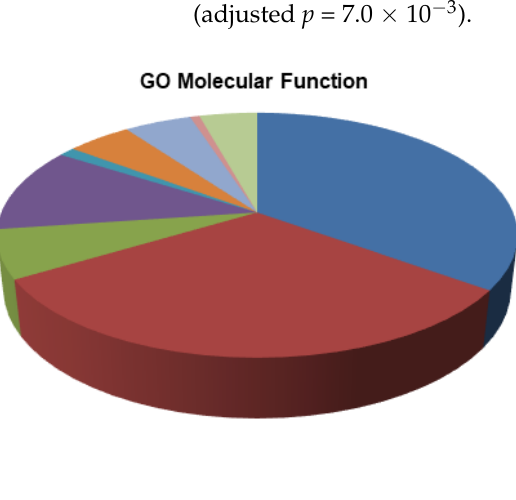
Figure 5. Transcripts per million (TPM) in normal (green) and tumor (red) lung tissues of those genes identified as strongly validated miRNA targets. ( A ) C19MC cluster and ( B ) MIR371-3 cluster. T: Tumor Tissue; N: Normal Tissue; ADC: Adenocarcinoma Lung; SCC: Squamous Cell Carcino- ma. * ANOVA test with p -value < 0.01.